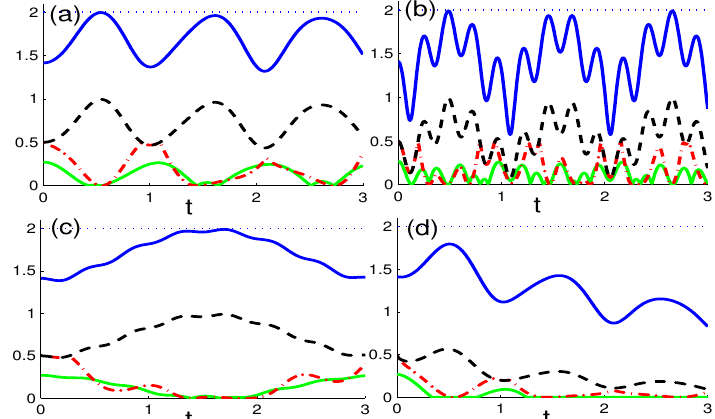
Figure 5. The L ( t ) (dashed plots), U ( t ) (dashed dotted plots), B ( t ) (upper solid plots), and N ( t ) (solid plots) for J x = J z = 2 and p = 0.5 with the cases ( χ z , ∆ , γ ) = ( 0.5,1.5,0.0 ) in ( a ); ( χ z , ∆ , γ ) = (3, 1.5, 0.0) in ( b ); ( χ z , ∆ , γ ) = (0.5, 0.5, 0.0) in ( c ) and ( χ z , ∆ , γ ) = ( 0.5,1.5,0.4 ) in ( d ). Case B: p ∈ [ p c , 1 ]